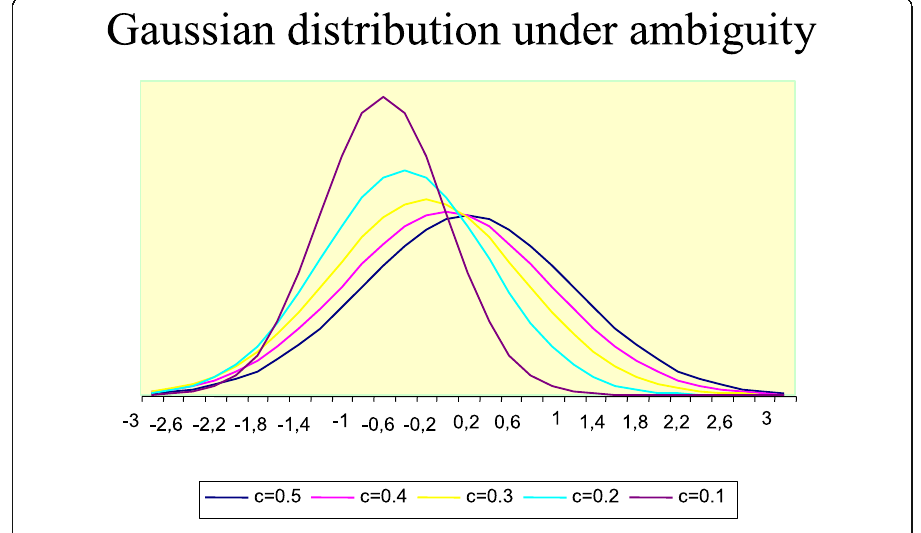
Fig. 1 Gaussian distribution under several ambiguity levels,